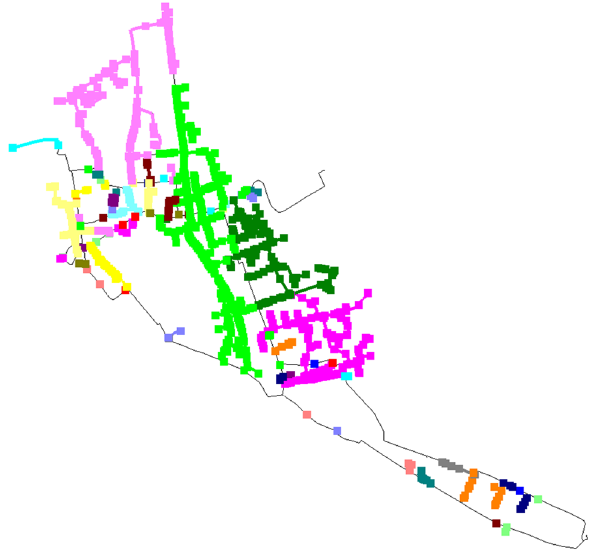
Fig. 4 The analyzed zone divided into DMAs generated by means of the WaterGEMS software (DMA-Tool)